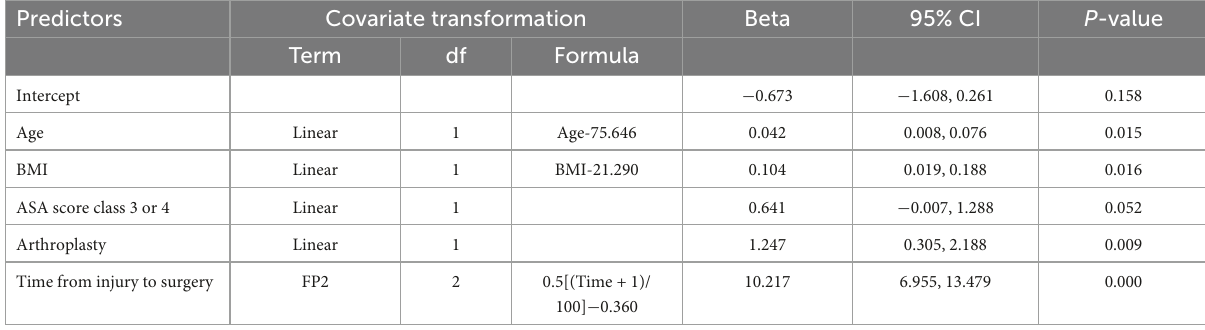
TABLE 3 Multivariable fractional polynomial logistic regression model for prolonged length of stay in patients with osteoporotic femoral neck fracture (final model).